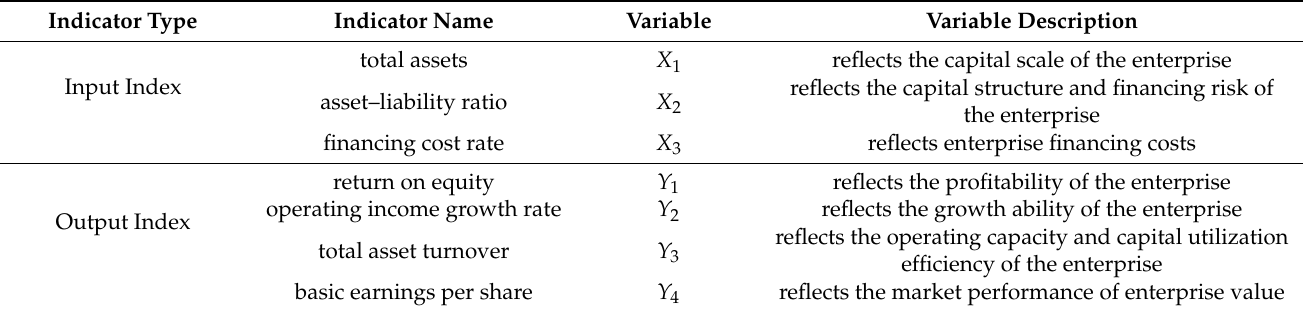
Table 1. Index selection results of the DEA